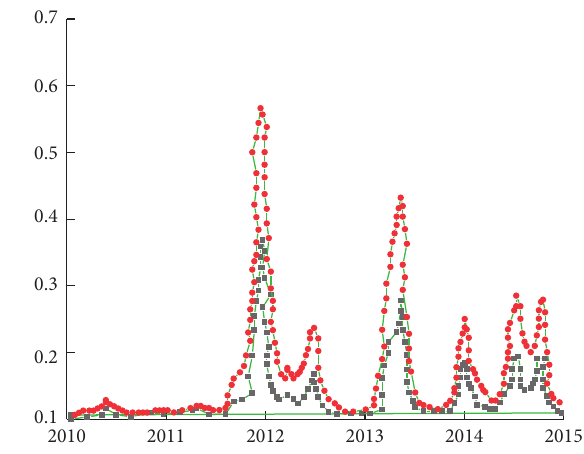
Figure 5: Posterior